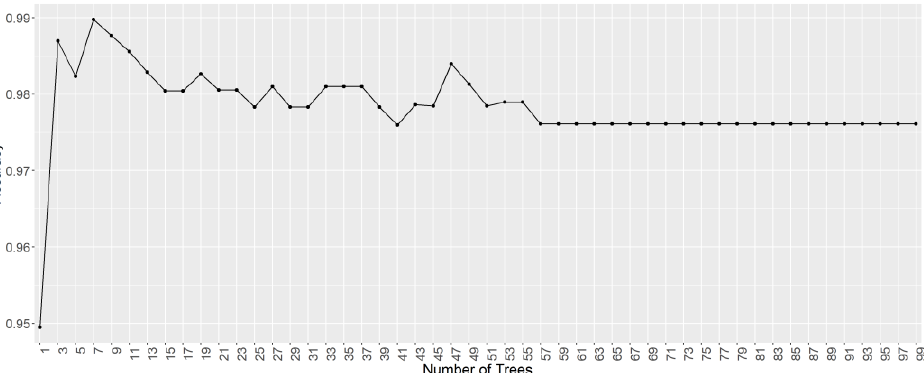
Figure 4. Accuracy of the RF model according to the number of trees. The model accuracy with the training set was 100%. In addition, two external valida- tions were performed on the OOB and LOOCV sets, with accuracy levels at 97.24% and 100%, respectively. It was, therefore, confirmed that a highly reliable and accurate model was obtained.